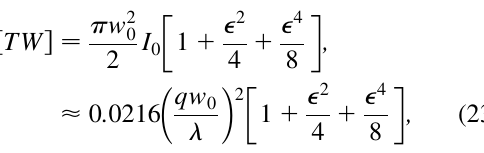
FIG. 8. (Color) Energy gain vs the beam waist radius w the laser output power fixed. Injection is into the beam focus (cid:3) 0 . Note that in (b) we zoom in on a small part of (a) and 0 and that the inset in (b) shows yet a smaller portion of the same data. The legends and parameter values in (a) apply to the other figures as